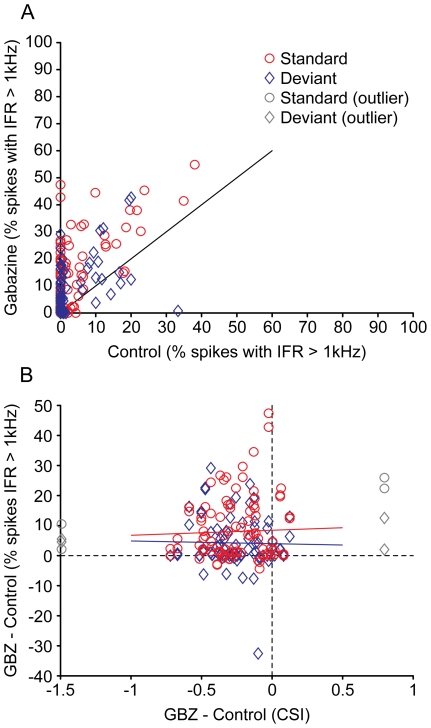
Effect of gabazine on firing rate saturation.(A) Percentage of spikes with an instantaneous firing rate (IFR) faster than 1 kHz. Each data point represents one stimulus (f1 or f2) at one probability (standard or deviant), for each recorded unit (i.e. each unit produced 4 data points). Blue diamonds indicate standard stimuli; red circles indicate deviant stimuli. (B) The increment in the percentage of IFR faster than 1 kHz during application of gabazine is not correlated with the increment in CSI. As in (A), each data point represents one stimulus at one probability, for each recorded unit. The CSI values are those calculated for the corresponding unit. The lines are the linear regression for the standard (blue) and deviant (red) stimuli. The data points that deviated more than 3 standard deviations from the mean increment in CSI were considered outliers (grey) and were not included in the fitting.